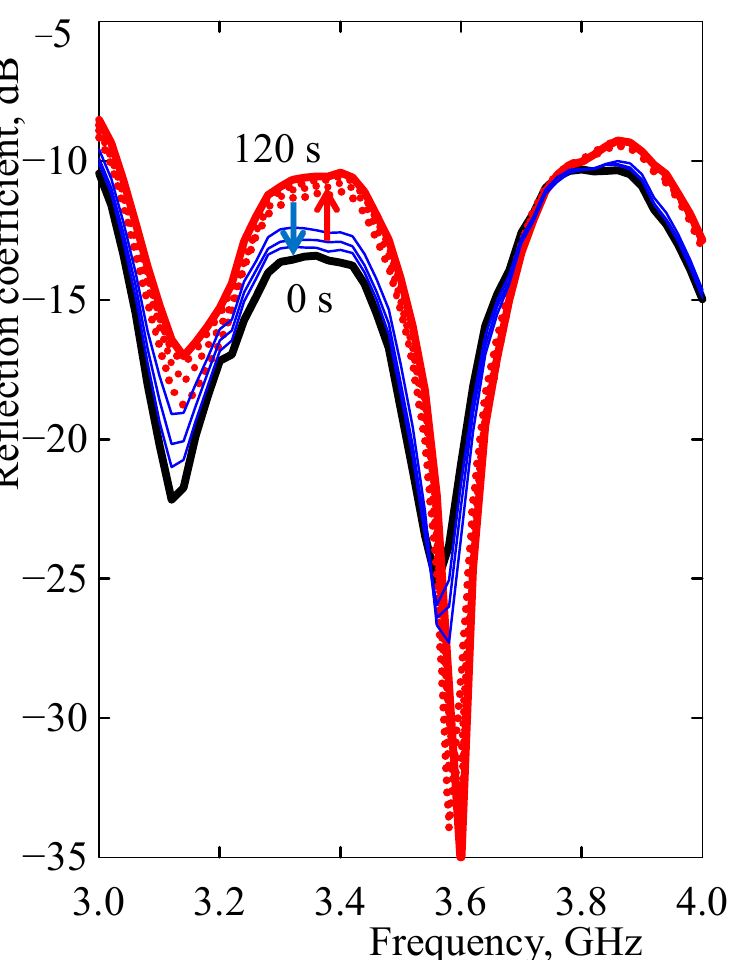
Figure 10. The frequency dependence of the MWCNT/EOC microstrip sensor reflection coefficient in the course of the adsorption and desorption of saturated heptane vapor. The sensor reflection coefficient spectrum in the initial state prior to vapor exposure at 0 s is represented by the thick black line. The dependence after the exposure to heptane for 15, 30, or 60 s is indicated by the dotted red lines and for 120 s by the thick red line. The dependence in the course of heptane desorption for 15, 30, 60, or 120 s is denoted by thin blue